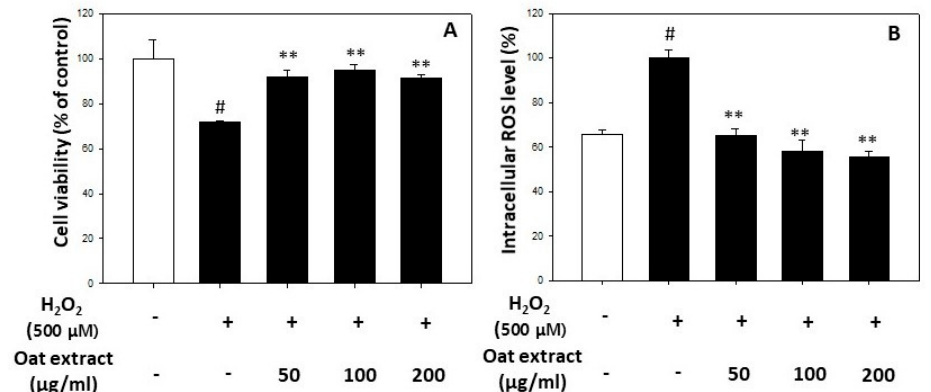
Figure 3. Protective effect of oat ( Avena sativa cv. Daeyang) 80% ethanol extract on hydrogen peroxide- induced cell death ( A ) and intracellular reactive oxygen species (ROS) levels ( B ). To determine the cell viabilities, HaCaT cells were pre-treated with various concentrations of oat 80% ethanol extract for 24 h, then cell medium containing oat 80% ethanol extract was removed, and further incubated with hydrogen peroxide for 24 h followed by MTT assay. To determine the intracellular ROS levels, HaCaT cells were treated with various concentrations of oat 80% ethanol extract in the presence of hydrogen peroxide for 3 h followed by DCF-DA fluorescence assay. Data are expressed as mean ± SD. # p < 0.05 vs. vehicle-treated cells; * p < 0.05, ** p < 0.01 vs. H 2 O 2 treated cells.